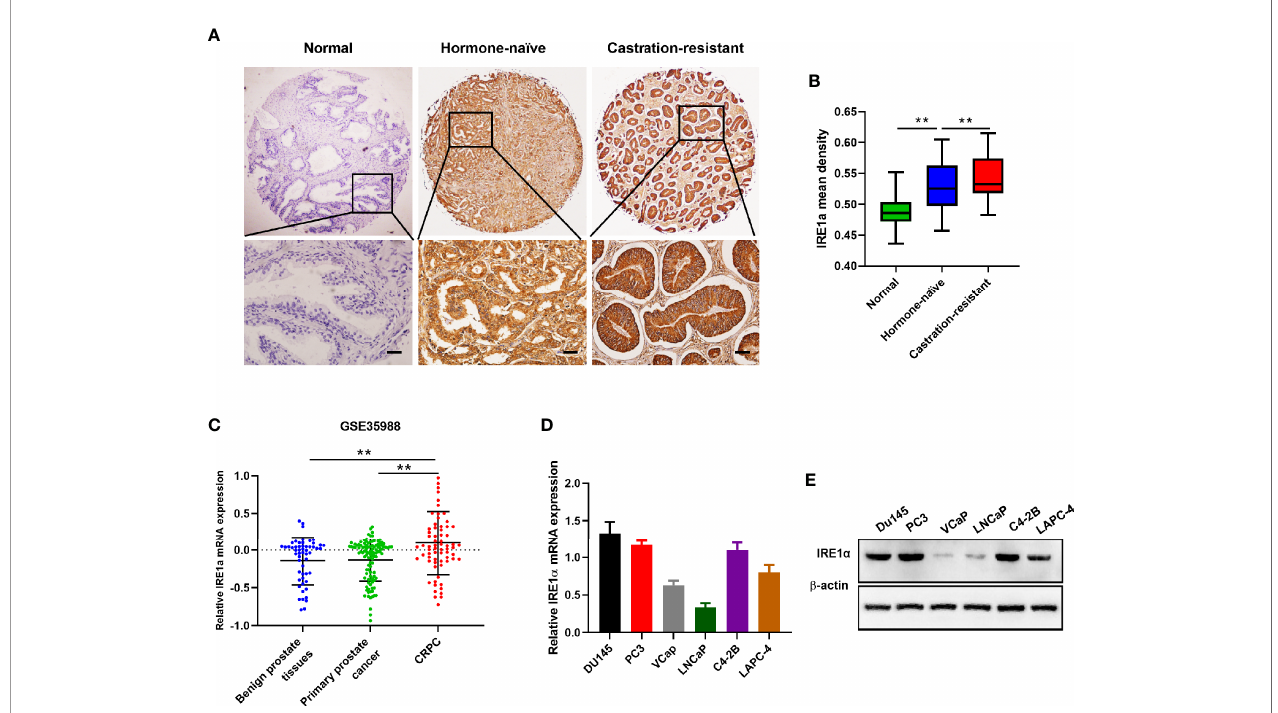
FIGURE 1 | IRE1 a is upregulated in CRPC tissues and cell lines. (A, B) Representative IHC staining images and mean IHC scores of IRE1 a in adjacent non- cancerous tissues, hormone naïve prostate cancer and CRPC tissues (n=80; Scale bars, 200 m m; **P < 0.01). (C) Expression pro fi le of IRE1 a was obtained from a GEO dataset (GSE35988). (D, E) qPCR and western blot analysis for the mRNA and protein expression of IRE1 a in prostate cancer cell